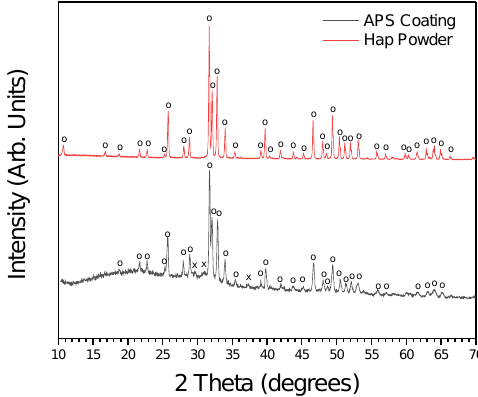
Figure 2. XRD diffractogram of Hap powder used, from Bioceramed S.A (Hap (ICDD ref.: 01-084- 1998)) and of APS Hap coating. Hap and β -TCP crystalline phases are detected, including the habitual amorphous halo observed in APS coatings (O-Hap (ICDD ref.: 01-084-1998); X- β -TCP (ICDD ref.: 04-006-9376)).